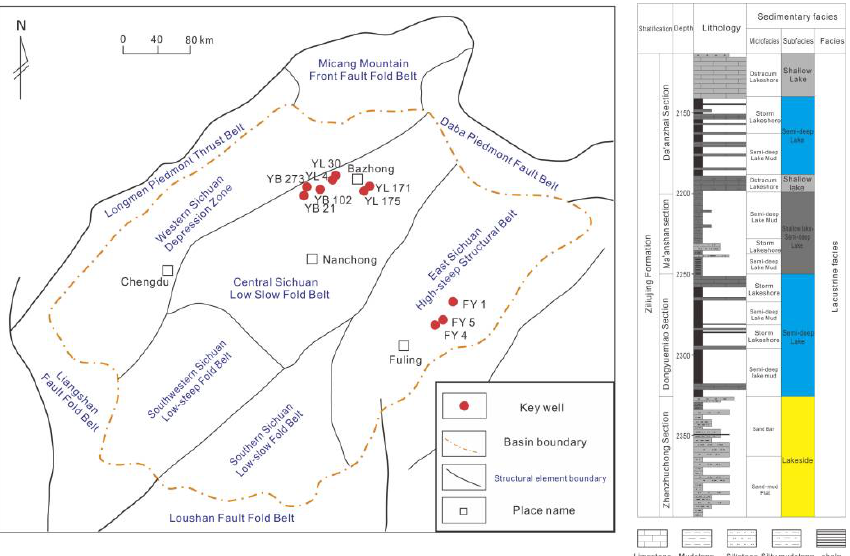
Figure 1. Structural of the Sichuan Basin and histogram of regional Lower Jurassic stratigraphy.